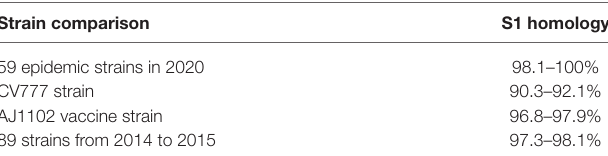
TABLE 1 | Comparison of S1 gene homology between PEDV epidemic strain and vaccine strain in